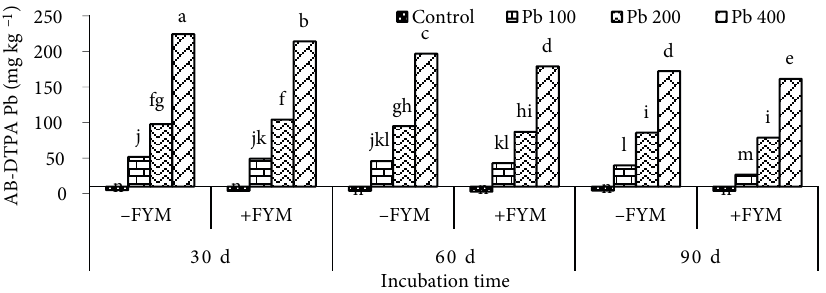
Fig. 4. Effect of incubation time on availability of Pb. FYM – farmyard manure; d – day. Lower case letters indicate the significance of treatments at P <